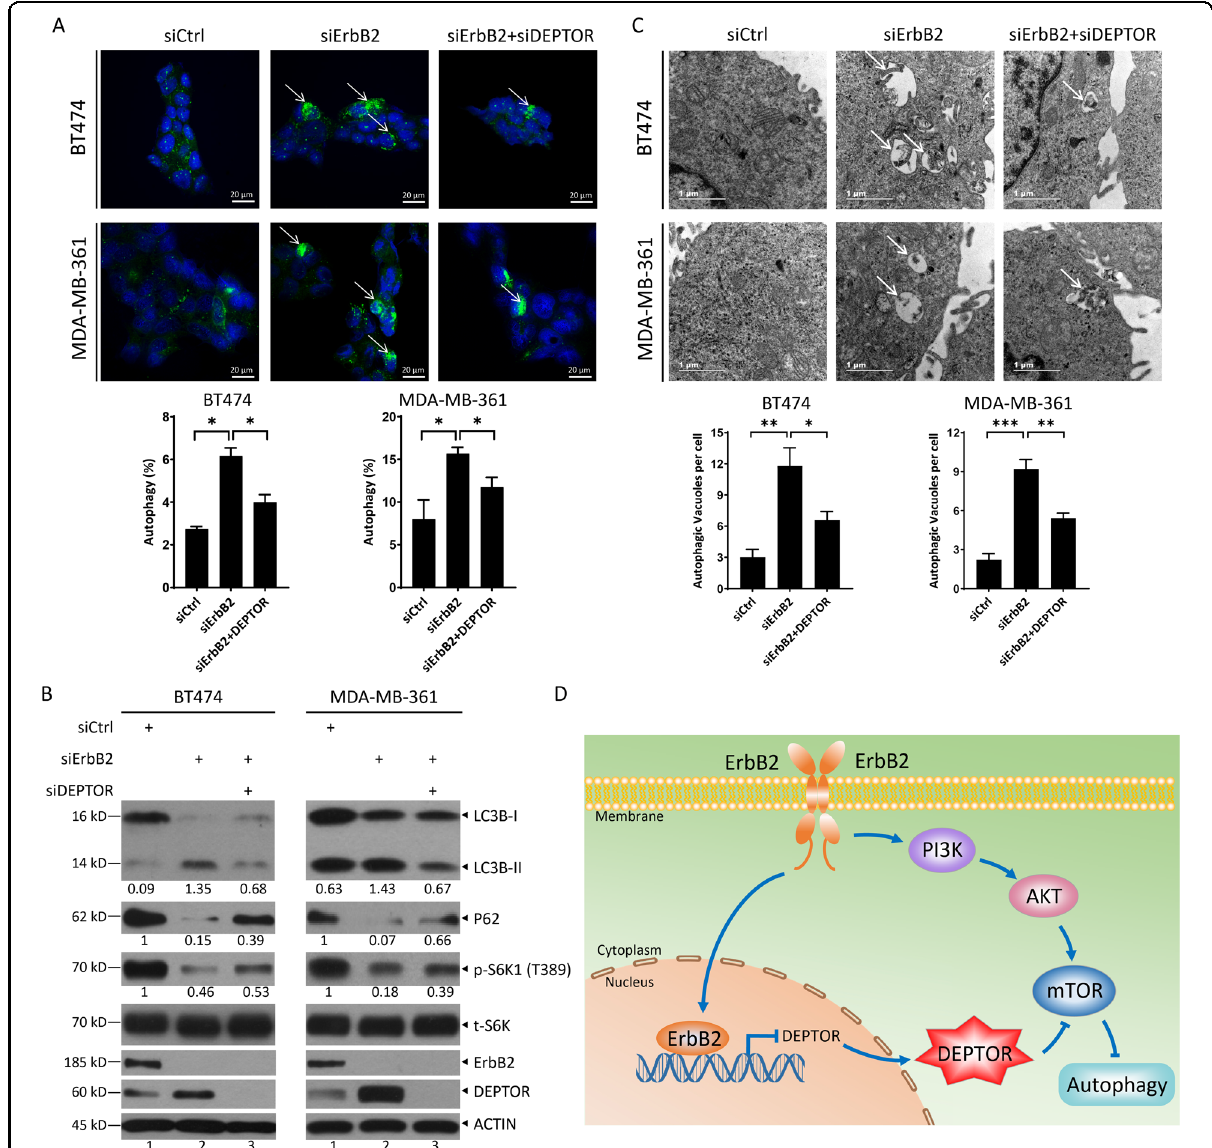
Fig. 4 ErbB2 knockdown induces autophagy through the induction of DEPTOR. A Autophagy was measured by appearance of punctate vesicle structure: BT474 and MDA-MB-361 cells were transfected with indicated siRNA for 48 h, and then subjected to immuno fl uorescence and photography under Nikon confocal microscopy. Scale bars represent 20 μ m. Cells with punctate vesicle structures of LC3 were counted and expressed as percentage of autophagy (bottom). * p < 0.05. B Autophagy was measured by LC3 conversion and p62 degradation: BT474 and MDA- MB-361 cells were transfected with indicated siRNA, followed by IB with indicated antibodies. The band density was quanti fi ed using Image J and expressed as relative gray value, compared with the control, by arbitrarily setting the control value as 1. C Autophagosomes detected by transmission electron microscopy (TEM). BT474 and MDA-MB-361 cells were transfected with indicated siRNA for 48 h, followed by TEM analysis. Autophagosomes were indicated by arrows. Direct magni fi cation: ×30 000. Scale bars represent 1 μ m. Autophagosomes were counted and expressed as autophagic vacuoles per cell (bottom). * p < 0.05, ** p < 0.01, *** p < 0.001. D A model for repression of DEPTOR transcription by nuclear ErbB2 to activate mTOR pathway and suppress autophagy. See text for